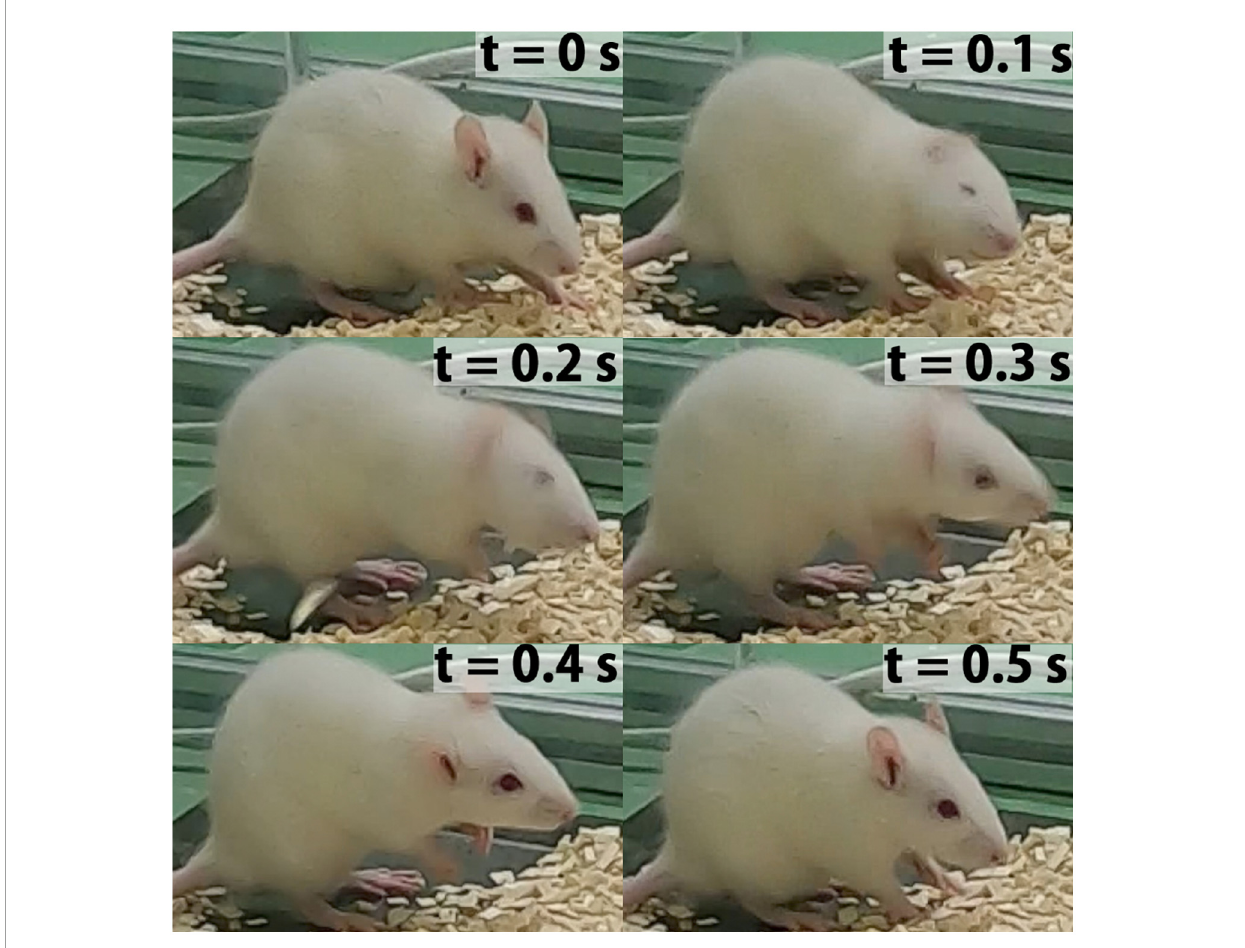
FIGURE2 Time-lapse sample frame sequence of WDS behavior recorded in this study ( t = 0 s previous to the start WDS behavior, t = 0.1–0.4 s WDS behavior, t = 0.5 s ending of WDS behavior). This behavior is evocative of the movement seen in